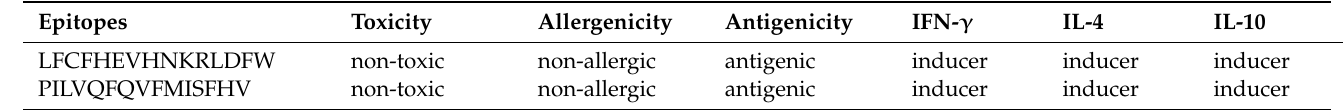
Table 1. The HTL epitopes selected after screening through the toxicity, allergenicity, antigenicity, IFN-Y, IL-4, and 1L-10 predictions.